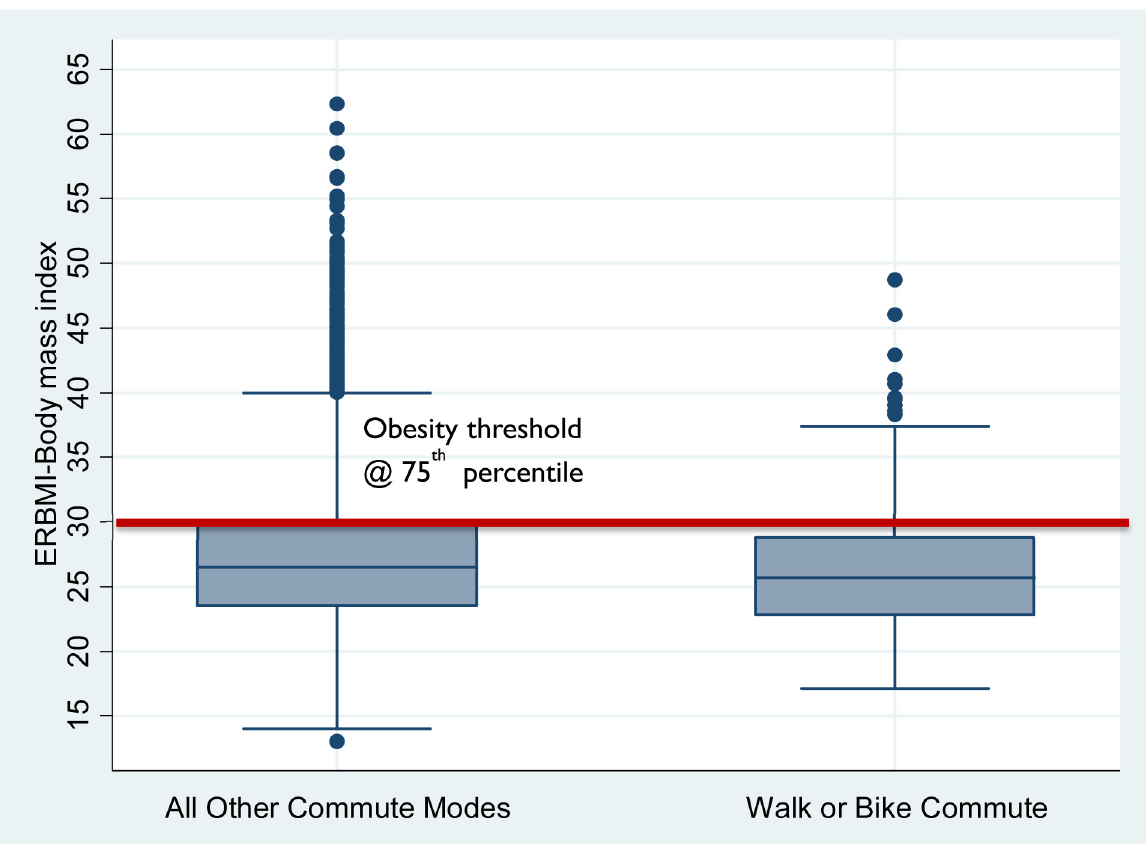
Fig 1. Boxplot of BMI by Active Commuting Status. Source: Authors ’ estimates using data from 2006 – 08 American Time Use Survey and Eating & Health Module.